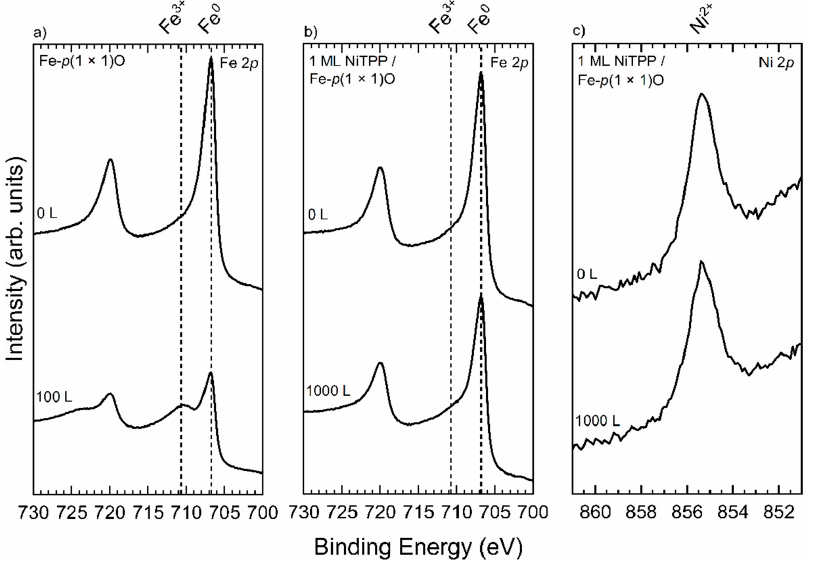
Figure 4. ( a ) Fe 2 p XPS spectra of the Fe– p (1 × 1)O surface before and after exposure to 100 L of O 2 . ( b ) Fe 2 p XPS spectra of 1 ML NiTPP/Fe– p (1 × 1)O before and after exposure to 1000 L of O 2 . In both the panels ( a ) and ( b ) the two vertical dashed lines mark the energy position of Fe 0 and Fe 3+ -derived peaks. ( c ) Ni 2 p XPS spectra of 1 ML NiTPP/Fe– p (1 × 1)O before and after exposure to 1000 L of O 2 . All the samples were exposed to molecular oxygen at RT. All the spectra were acquired with Mg K α ( h ν = 1253.6 eV) emission line. Micromachines 2021 , 12 , x FOR PEER REVIEW